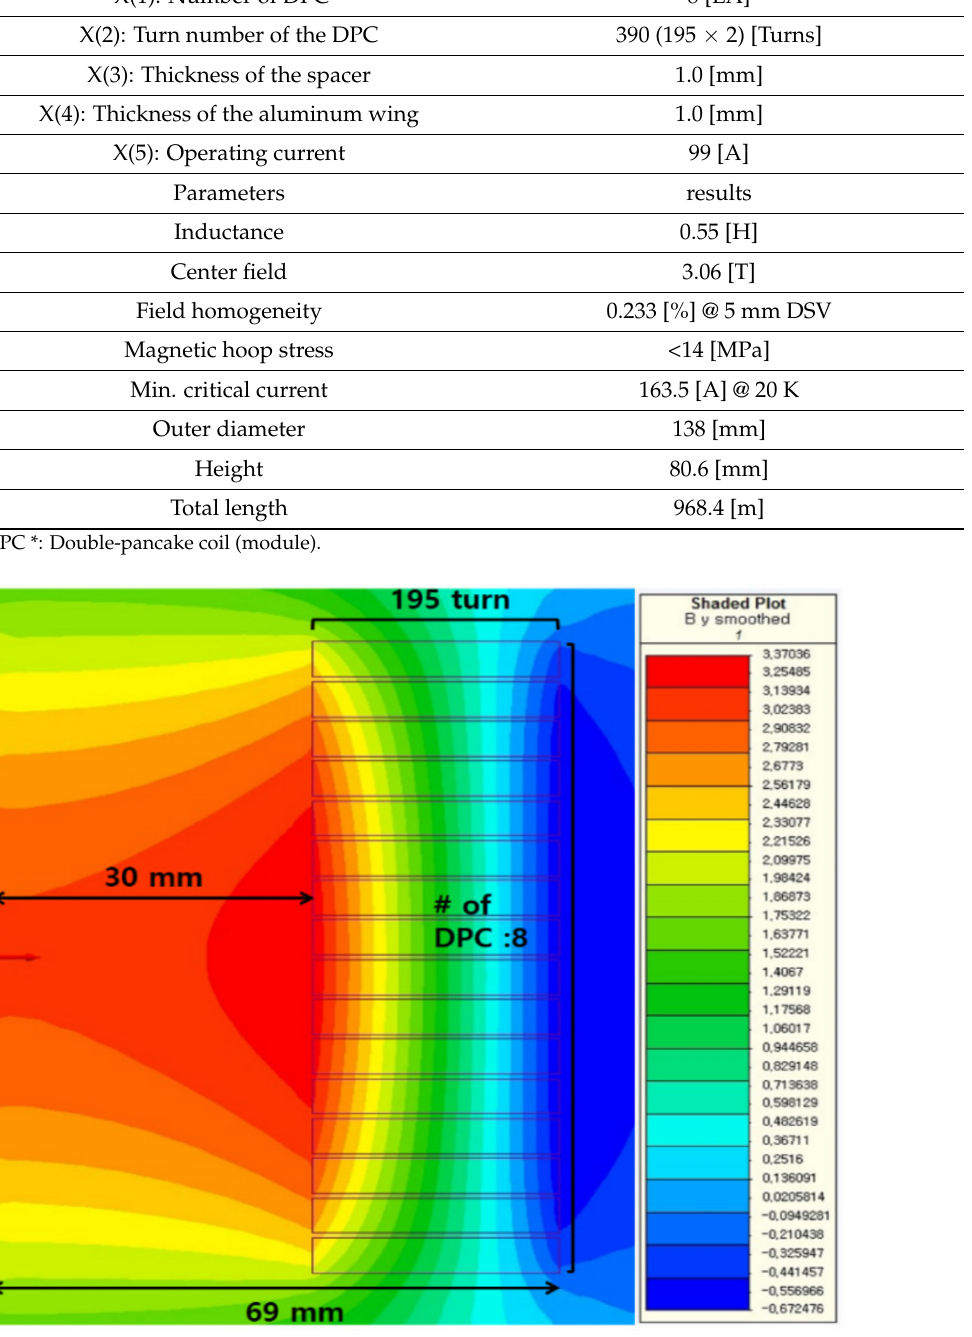
Figure 6. Magnetic field distributions of the 3 T REBCO magnet design result. The REBCO magnet is composed of eight coil modules, called double-pancake coils (DPC), and generates over 3 T at an operating current of 99